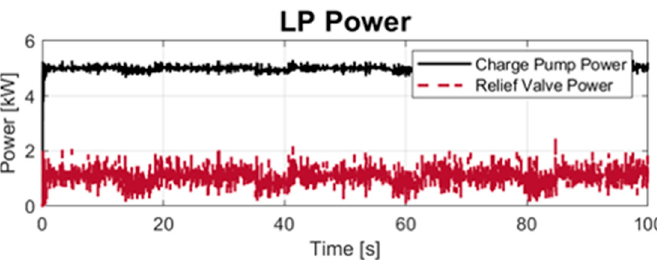
Figure 12. Low-pressure results of dynamic simulation.